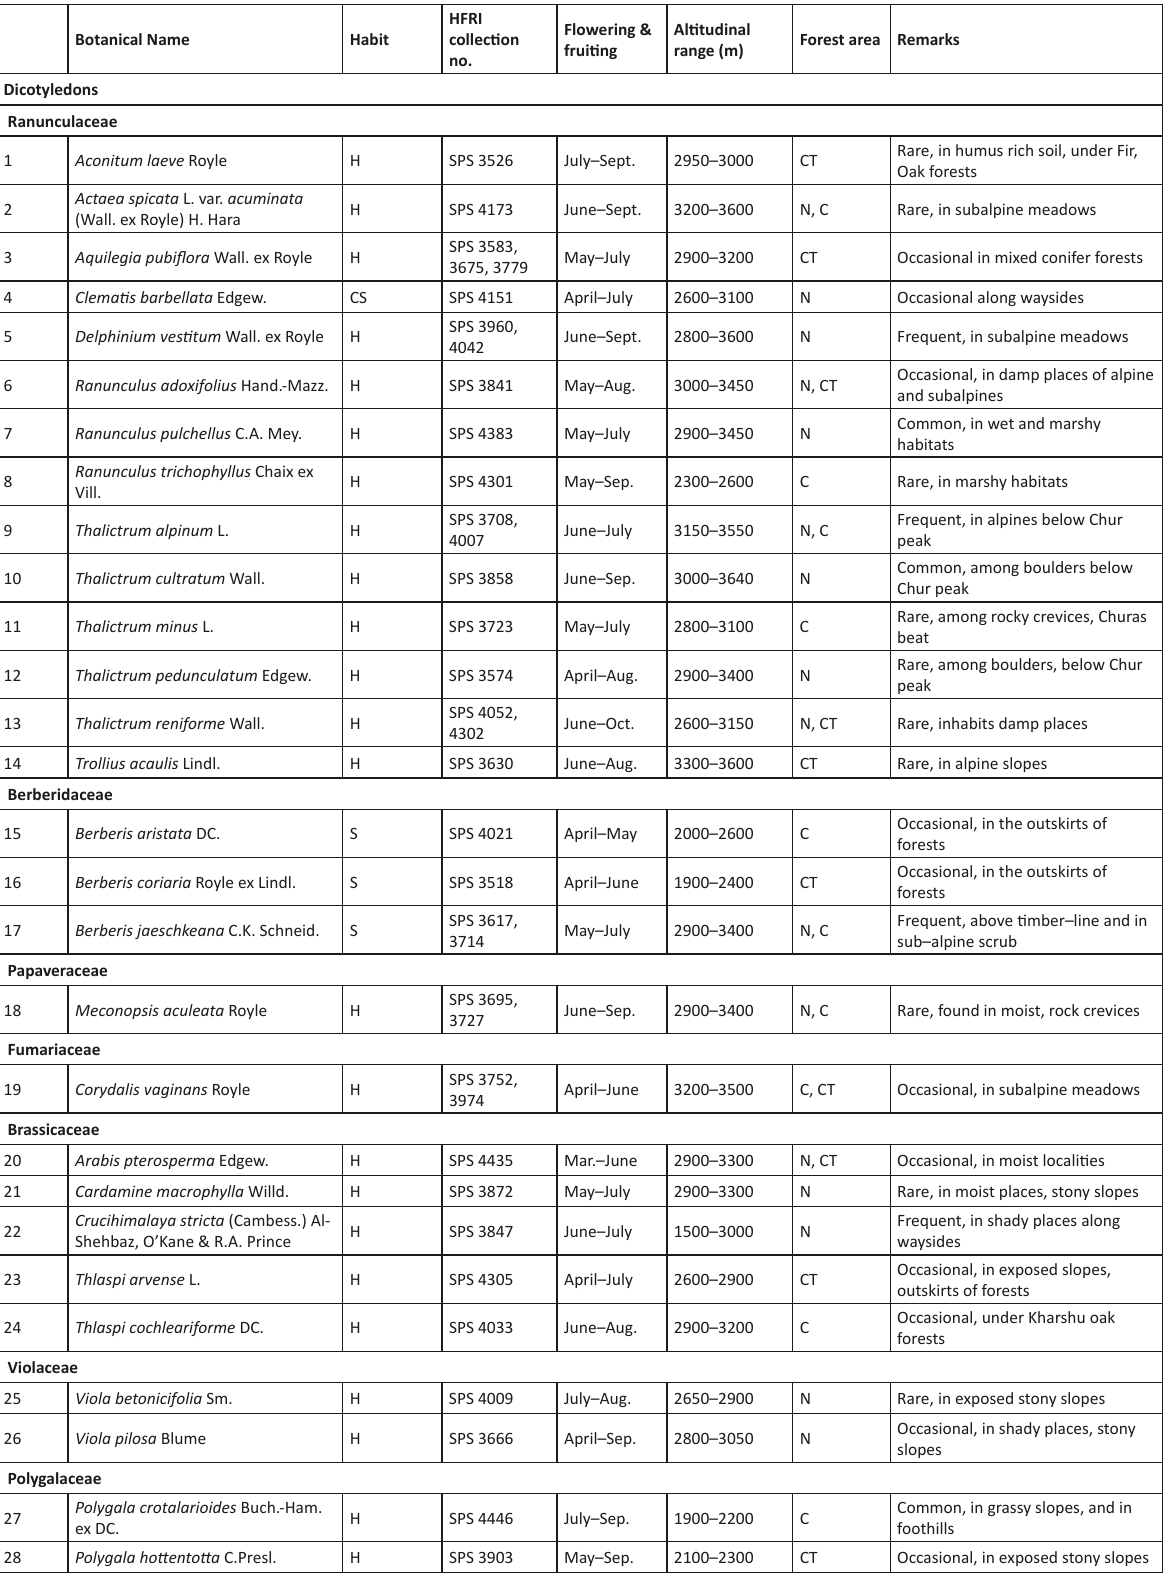
Table 1. List of the plant species which are additions to the Flora of Sirmaur District, Himachal